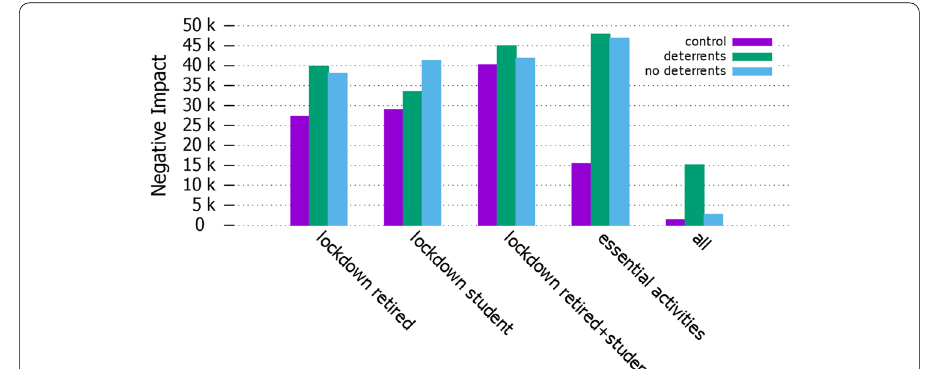
Fig. 11 Negative impact Comparison of negative impact value in different settings